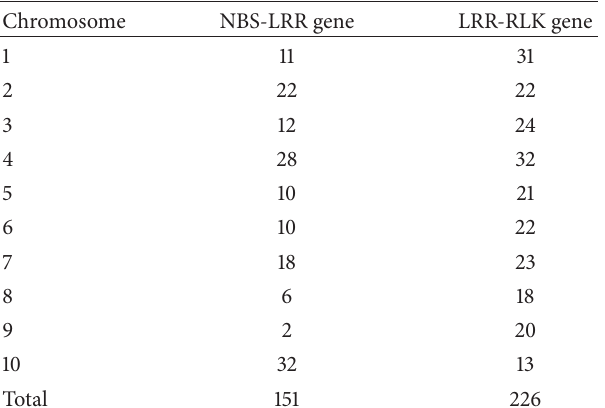
Table 2: Comparison of duplications of genes of NB-LRR and LRR- RLK in maize